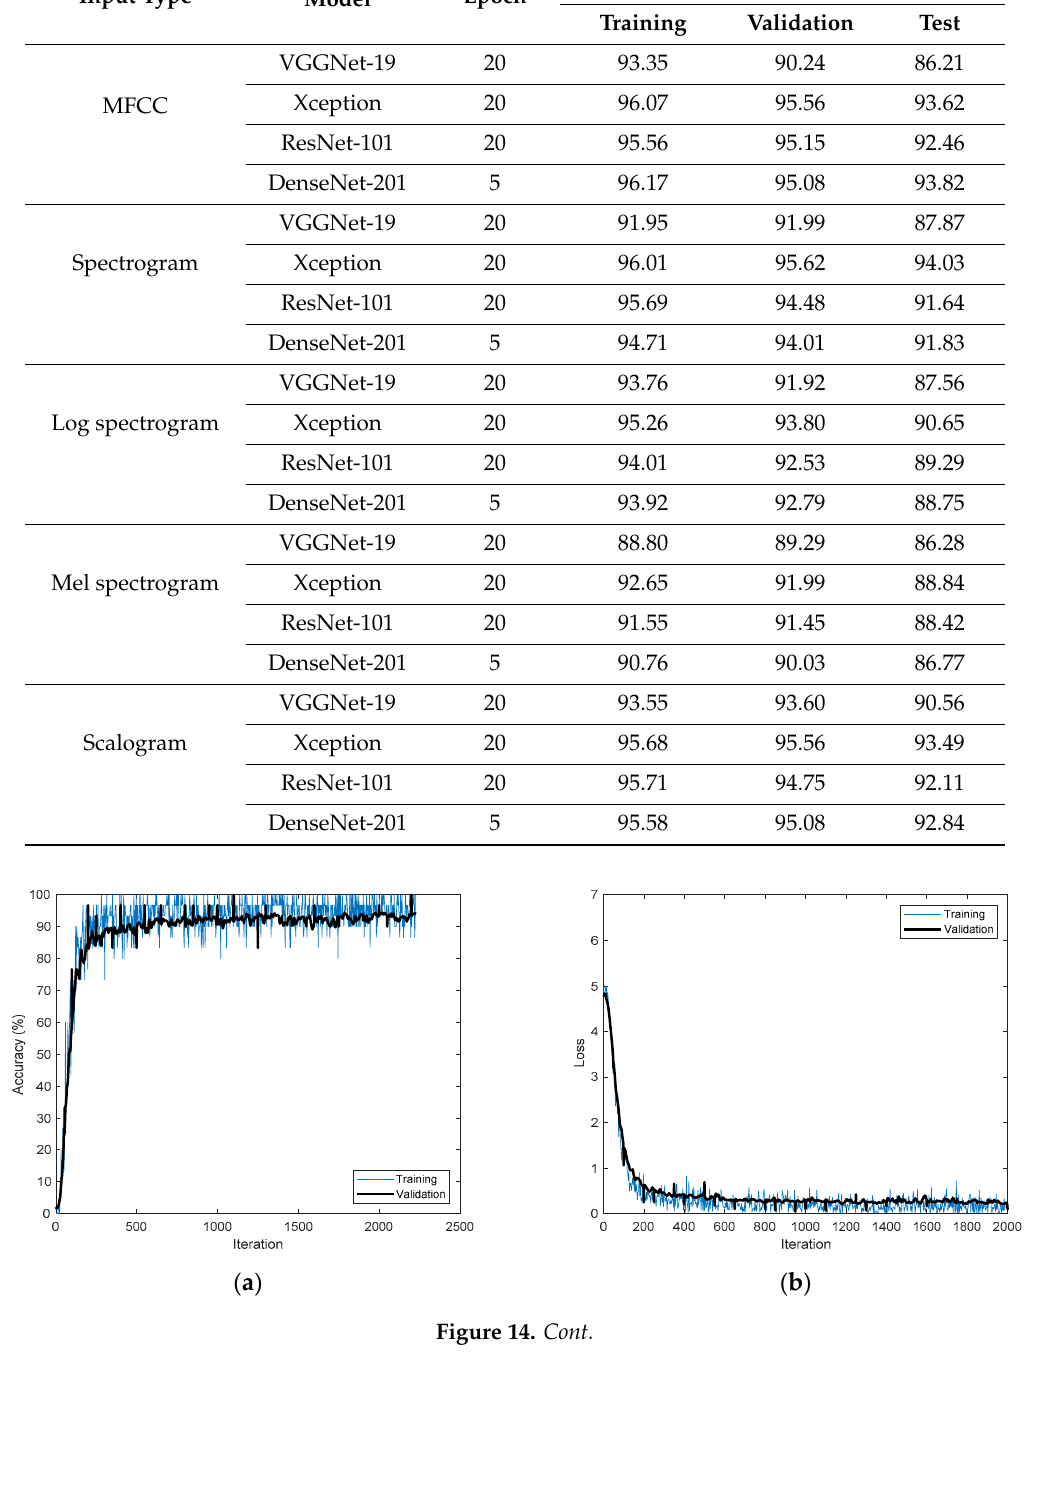
Table 6. Accuracies achieved by various models based on the CNN using time-frequency representations on CU-ECG.